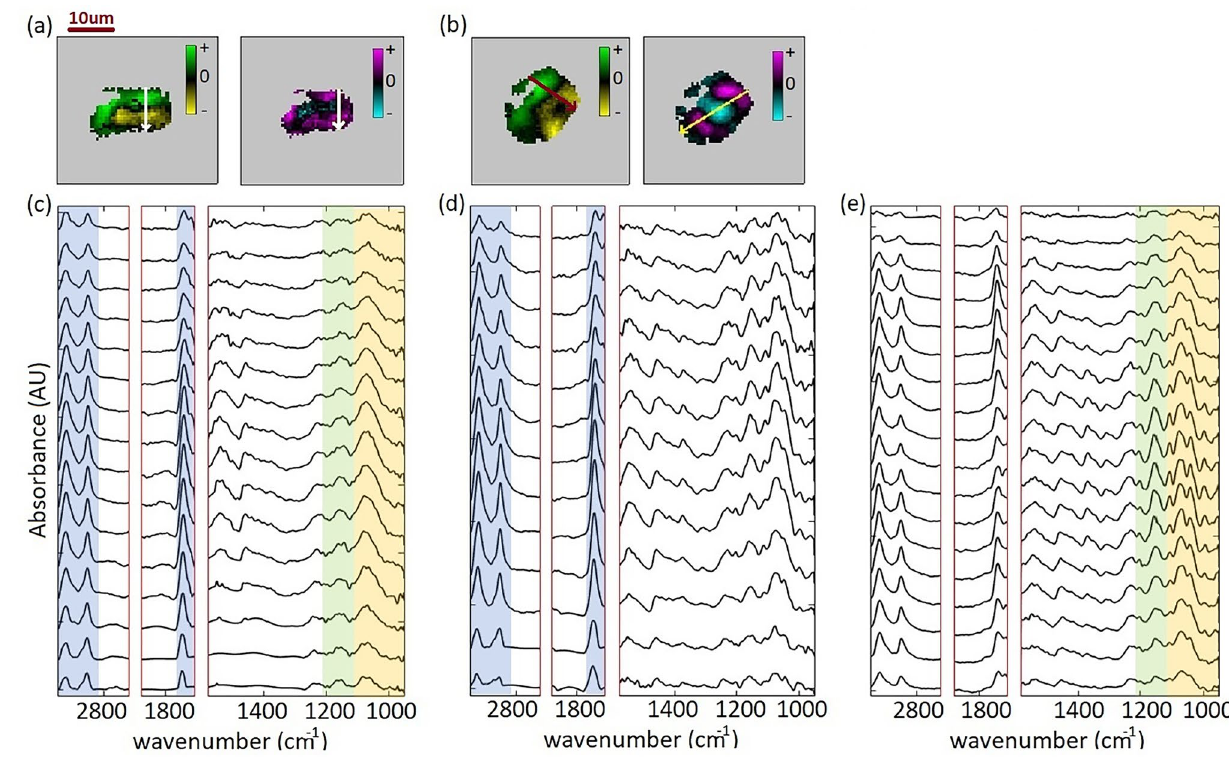
Figure 5. Principal component variance images and stack of spectra, 15 min after experiment start. Top: PC Score images of the first measurements show the intracell variance. Here arrows indicate the direction of the maximum spectral variations in the variance images. Below: stack of spectra (top to bottom) along the arrows. ( a ) First and second variance of the control cell. ( b ) First and second of the variance of the treated cell with low- to-high CO 2 concentration. ( c ) Stack of the spectra along the white arrow. ( d ) Stack of the spectra along the red arrow. ( e ) Stack of the spectra along the yellow